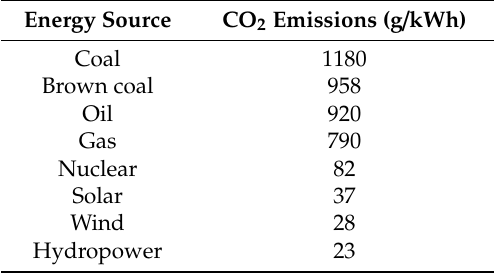
Table 4. CO 2 emissions depending on fuel and type of power plant